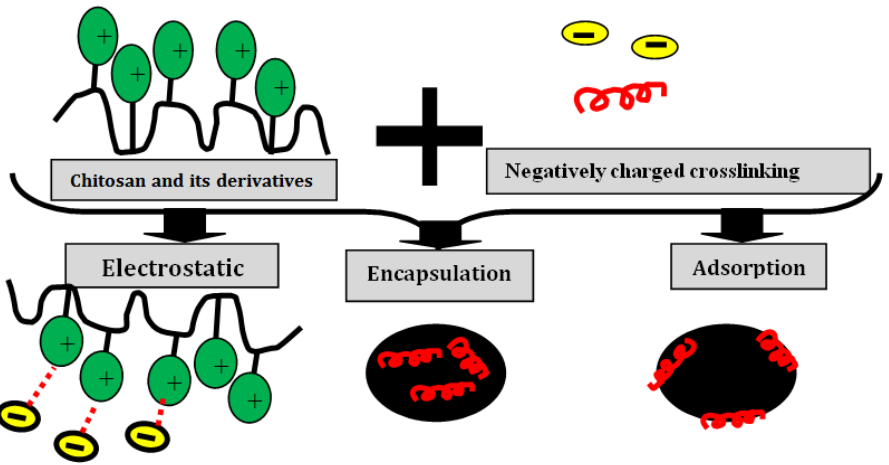
Figure 4. Schematic representation of different techniques for obtaining NPs based on chitosan and a cross-linking agent carrying an opposite charge.